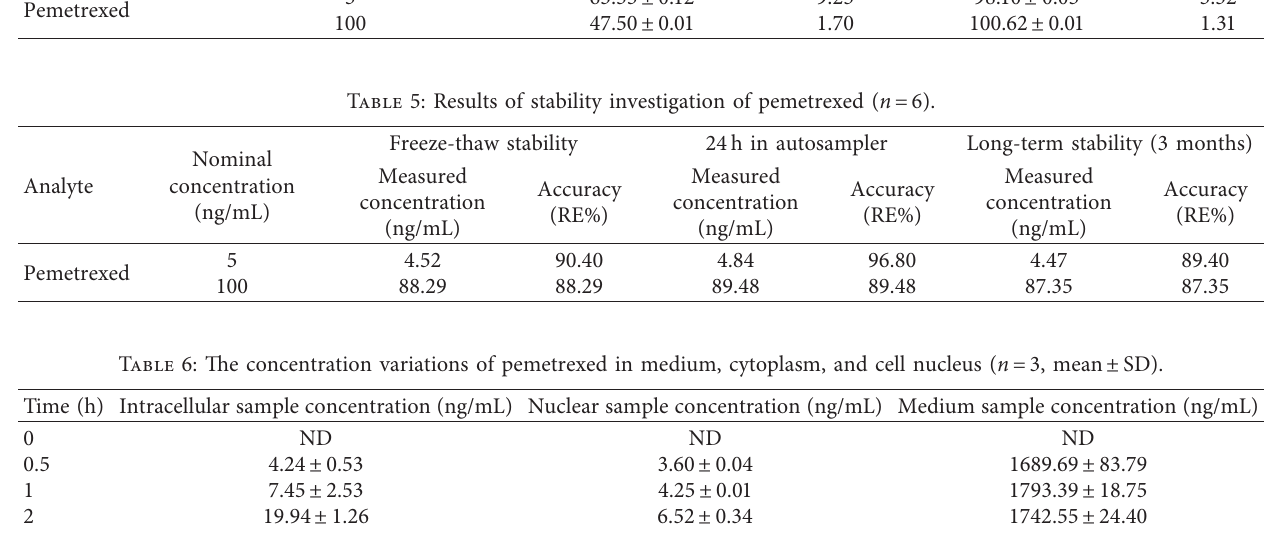
Figure 1: representative MRM chromatograms of peme- trexed. (a) Blank sample; (b) blank sample spiked IS; (c) blank sample spiked with LLOQ concentration of